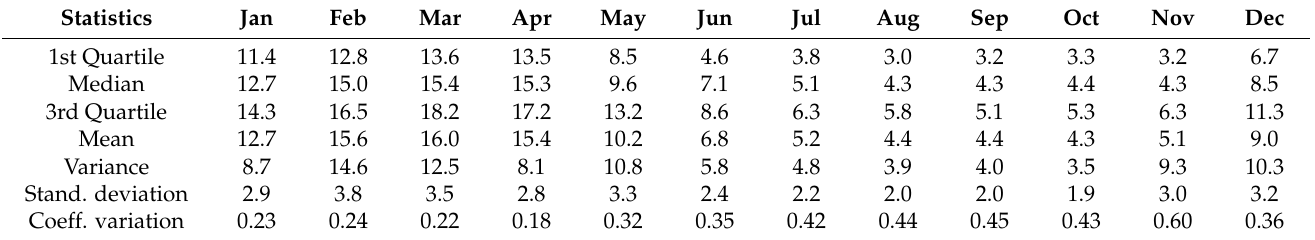
Table A1. Descriptive statistic calculated for the 1985–2020 historical series of Bel é m station PREC.